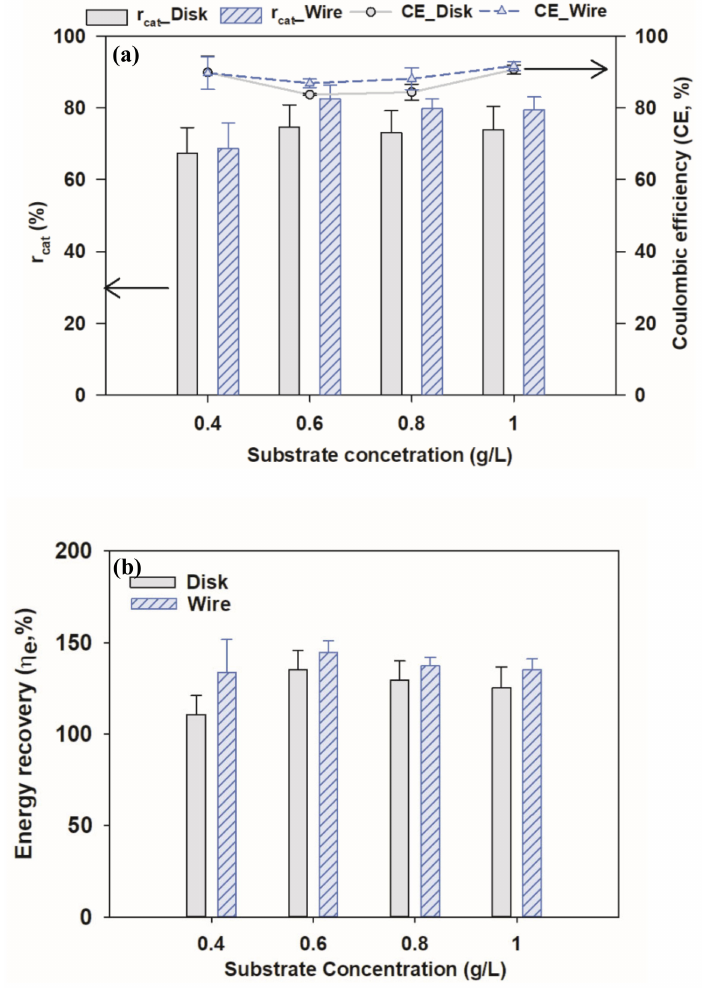
Figure 5. Efficiencies and hydrogen production yields of MECs with different cathode types at various substrate concentrations: ( a ) cathodic hydrogen recovery and coulombic efficiency and ( b ) energy